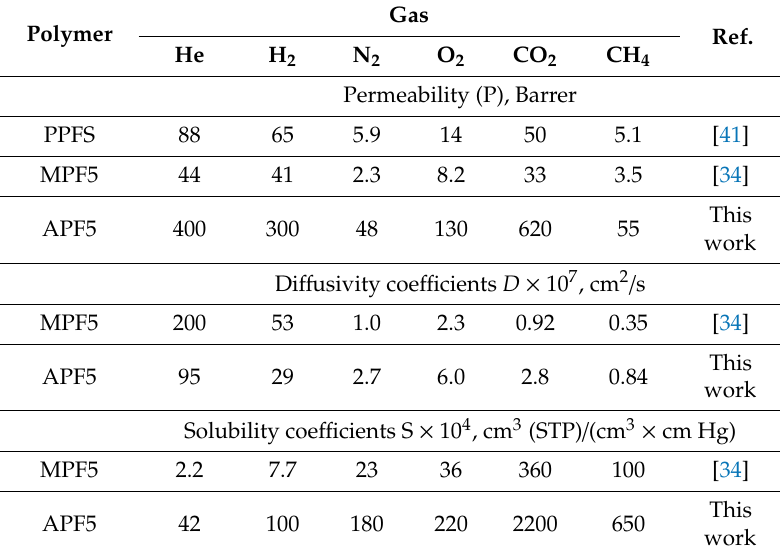
Table 5. Permeability, di ff usivity, and solubility coe ffi cients of various gases in